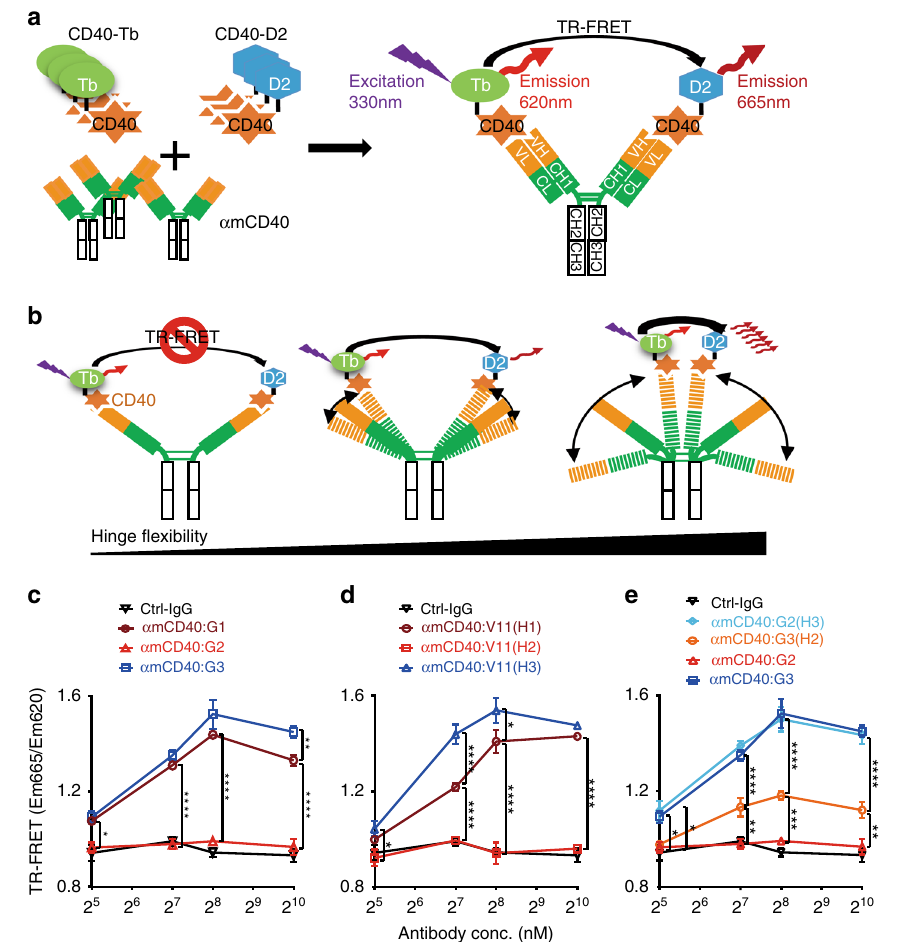
Fig. 5 The superior rigidity of IgG2 CH1-hinge. a A diagram showing anti-mCD40 antibody TR-FRET. Anti-mCD40 antibody molecules mixed with CD40- Tb and CD40-D2 (mCD40 labeled with Tb donor and D2 acceptor fl uorochromes, respectively) can simultaneously bind CD40-Tb and CD40-D2, and emit TR-FRET signal quanti fi ed as the relative ratio of detected 665 nm fl uorescence to 620 nm fl uorescence (Em665/Em620) upon stimulation. b A diagram of the model showing that hinge fl exibility of hIgG anti-mCD40 antibodies correlates with TR-FRET signal levels. Left, anti-mCD40 antibodies with little hinge fl exibility do not trigger TR-FRET signal due to the large distance between CD40-Tb and CD40-D2; middle, hinge fl exibility can bring CD40-Tb and CD40-D2 close enough to trigger TR-FRET signal; right, anti-mCD40 antibodies with large hinge fl exibility give rise to stronger TR-FRET signal due to more molecules with closer CD40 binding sites. c – e TR-FRET signal levels of anti-mCD40 antibodies of indicated constant domains. Shown are relative TR- FRET signal levels (Em665/Em620) plotted against the concentration of control IgG or the anti-mCD40 antibodies of indicated constant domains. Bars represent the mean ± SEM. * p ≤ 0.05, ** p ≤ 0.01, *** p ≤ 0.001, **** p ≤ 0.0001, two-way ANOVA with Holm – Sidak ’ s post hoc. Source data ( c – e ) are provided as a Source Data fi le. A representative of two independent experiments is